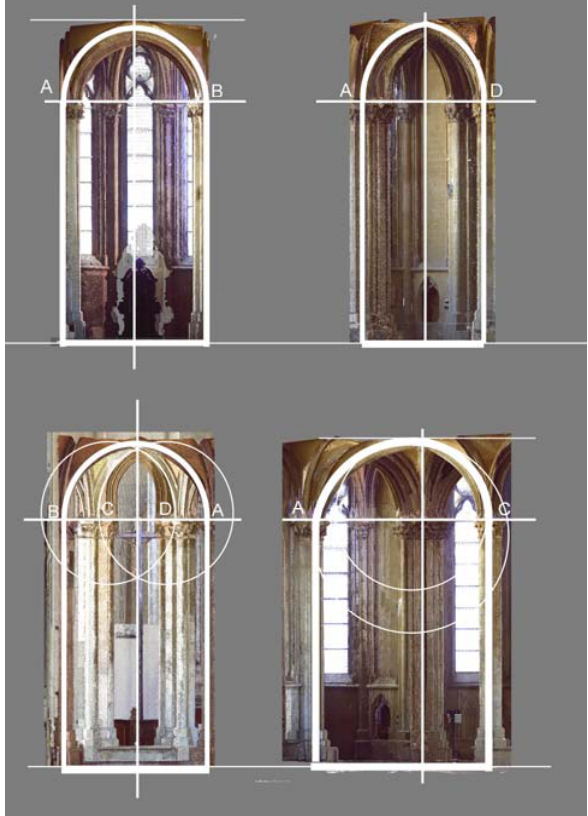
Figure 8 . Naples S. Lorenzo Maggiore. Gothic vaults geometry from laser scanner data.